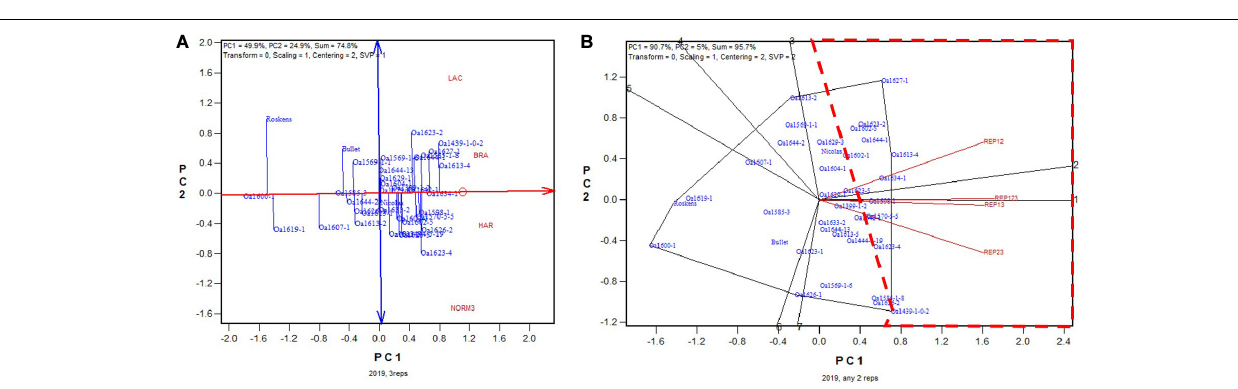
FIGURE 12 | Biplots for the 2019 non-Ontario trials. (A) GGE biplot to show genotype ranking based on data from all three replicates, and (B) summary biplot to show the genotype rankings based on all three replicates and on any two of them. REP123, genotypic ranking based on all three replicates; REP12, genotype ranking based on replicates 1 and 2; REP13, genotype ranking based on replicates 1 and